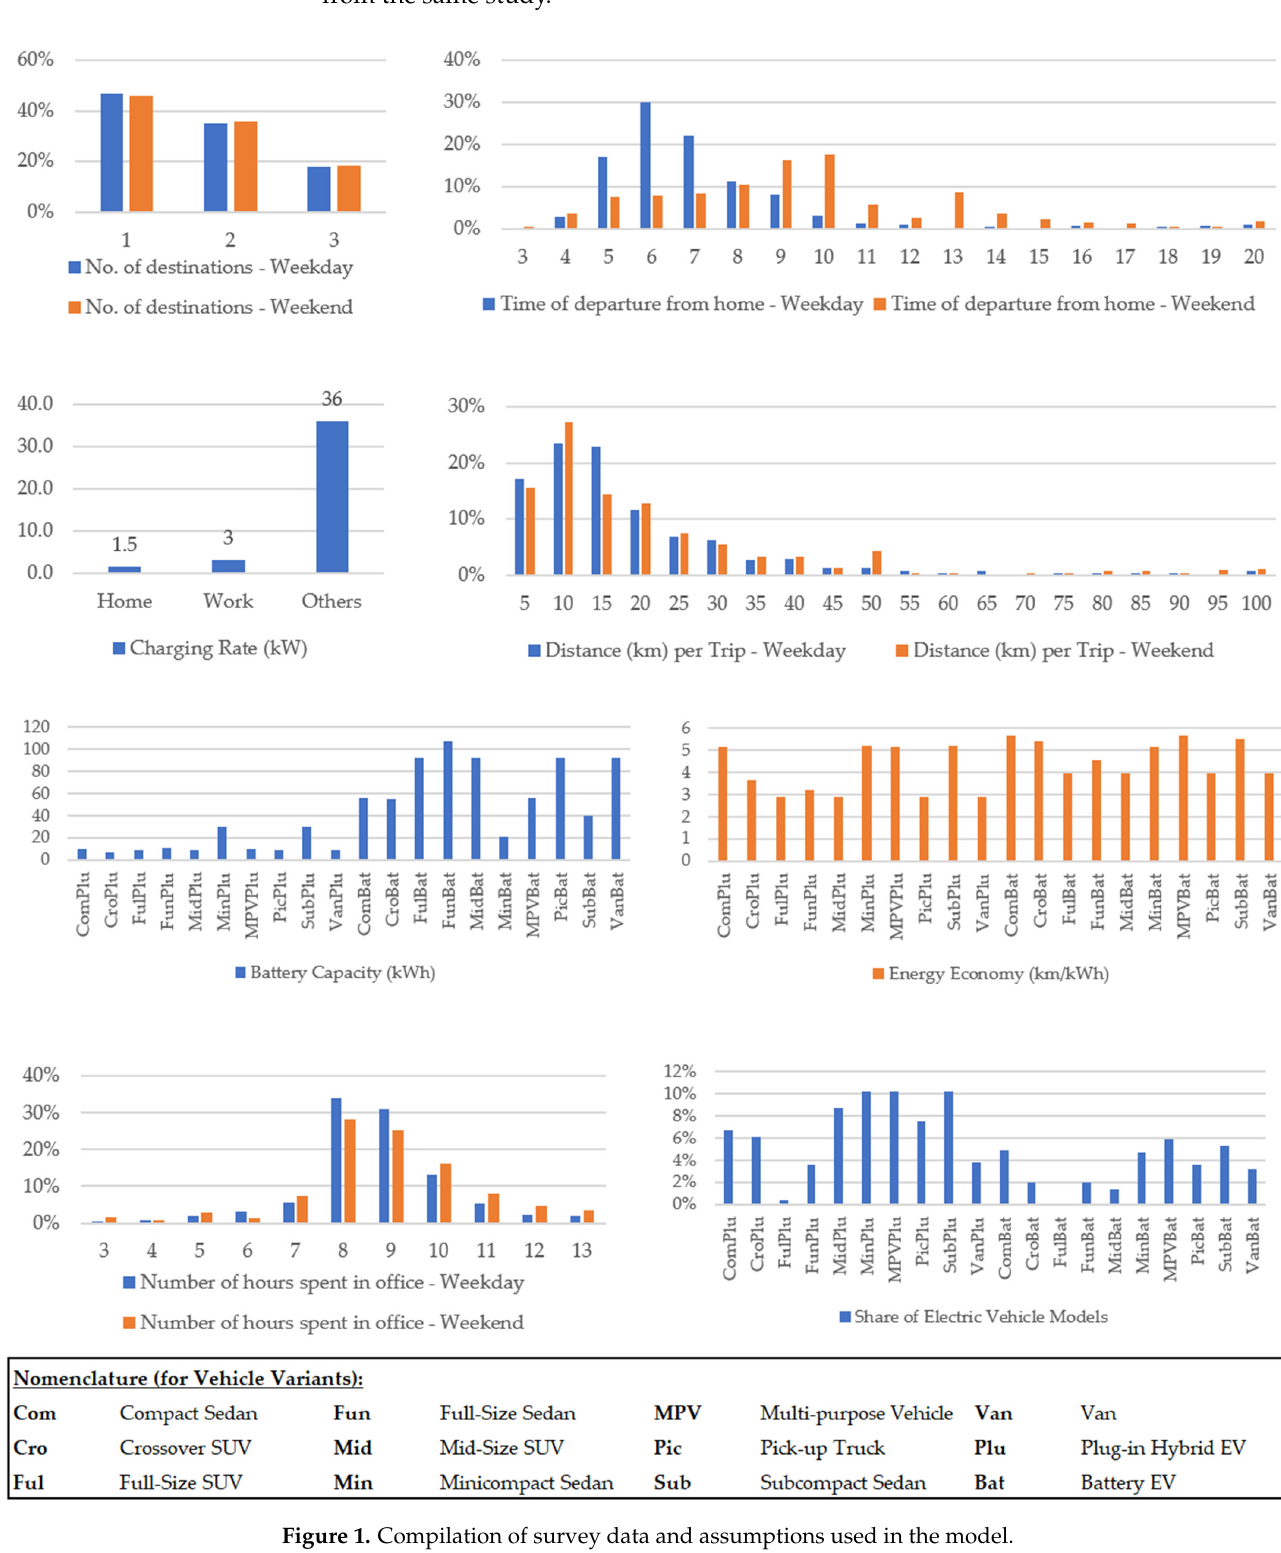
Figure 1. Compilation of survey data and assumptions used in the